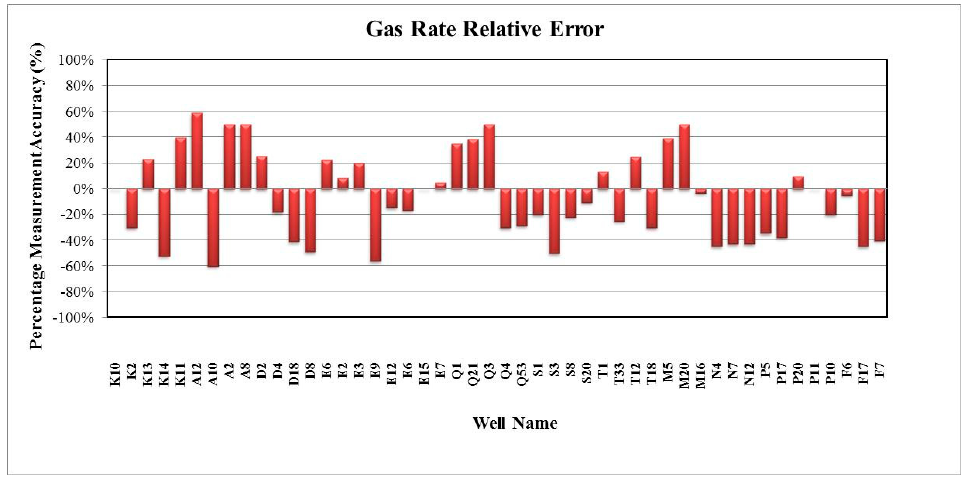
Figure 21. Water rate measurement accuracy using the Darcy correlation. Energies 2018 , 11 , x FOR PEER REVIEW